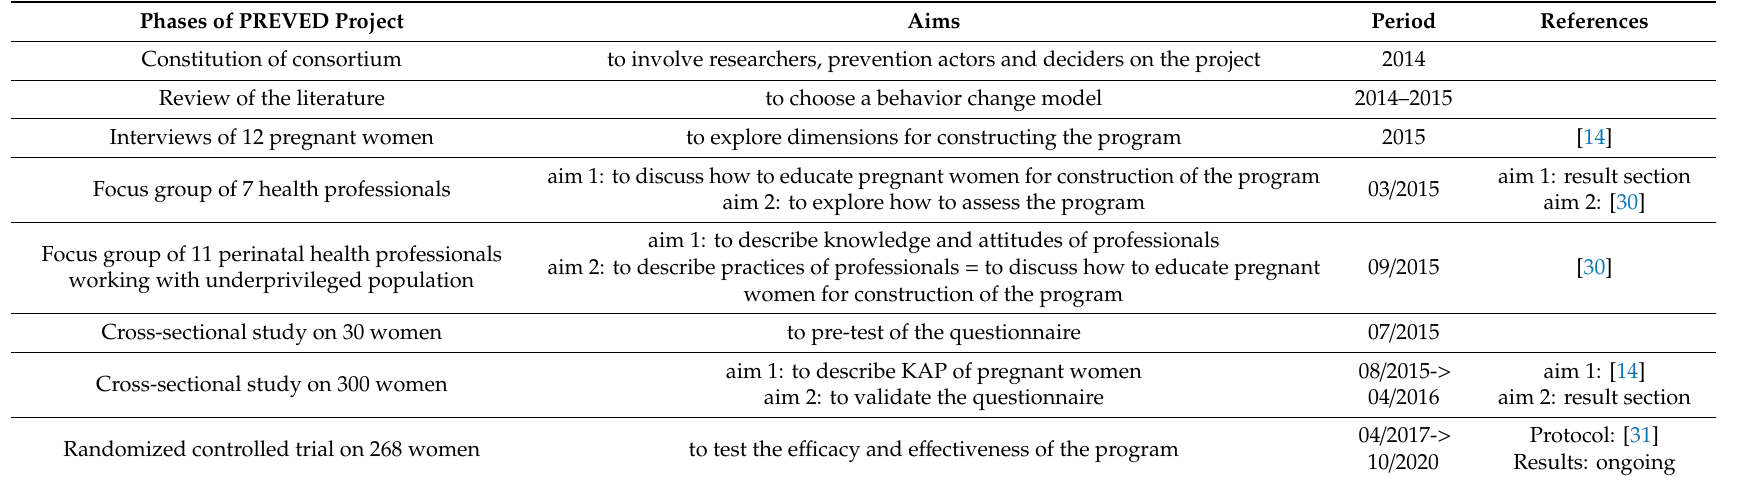
Table 1. Phases of the PREVED